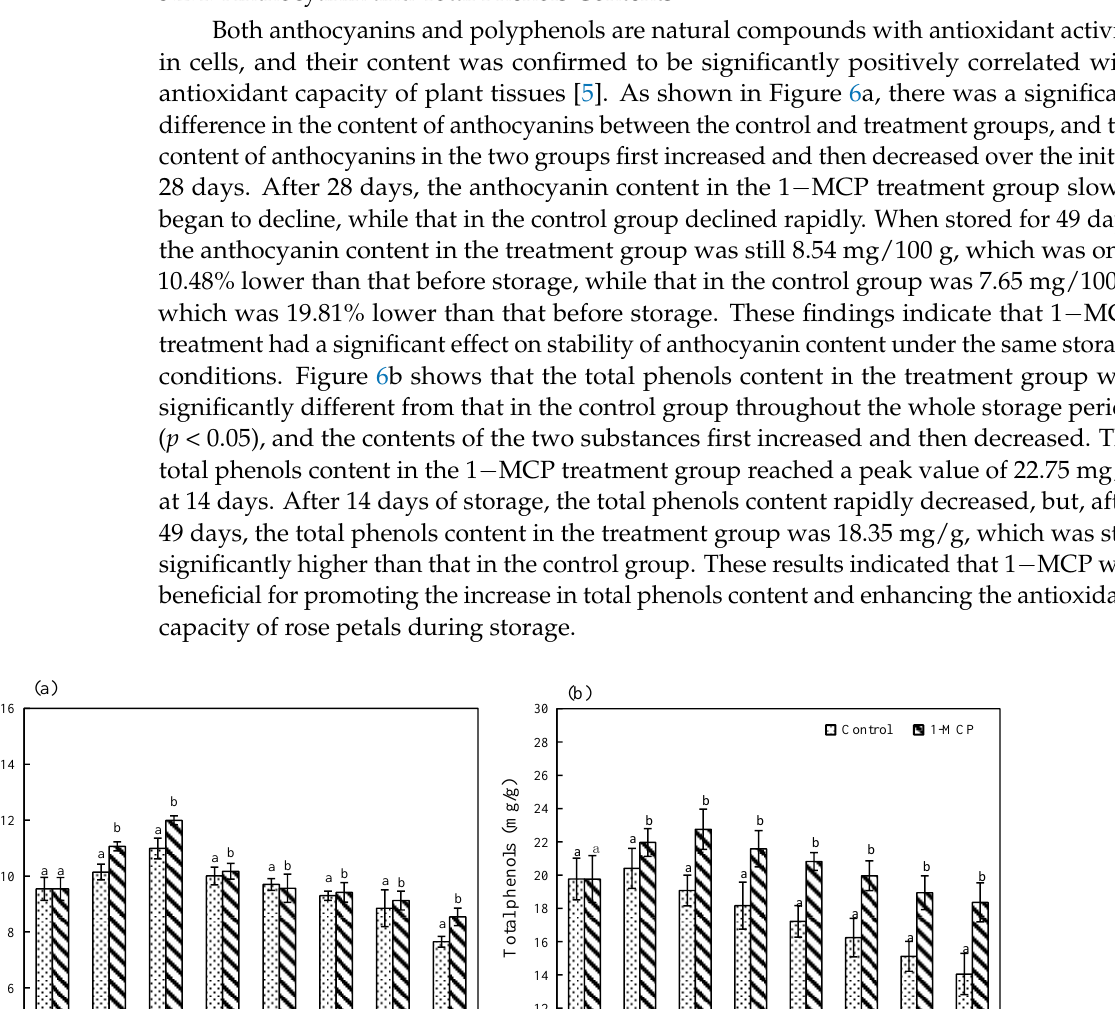
Figure 5. The effect of 1 − MCP on AsA content in the petals of ‘Dianhong’ rose du ring different storage periods .Different letters on the bar chart indicate significant differences among group ( p < 0.05, n = 3).